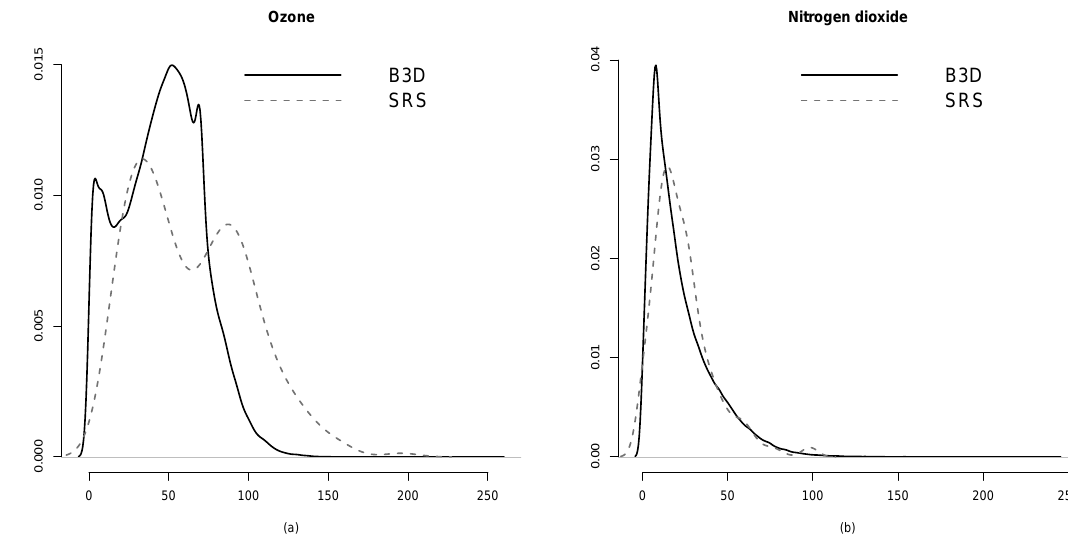
Figure 1. Estimated probability densities involved in the case study with air quality data. ( a ) Density of the ozone level in the last 15 years (solid black line) and its analogue for temperatures greater than or equal to 30 ◦ C (dashed gray line). ( b ) Density of the nitrogen dioxide level in the last 15 years (solid black line) and its analogue for temperatures greater than or equal to 30 ◦ C (dashed gray